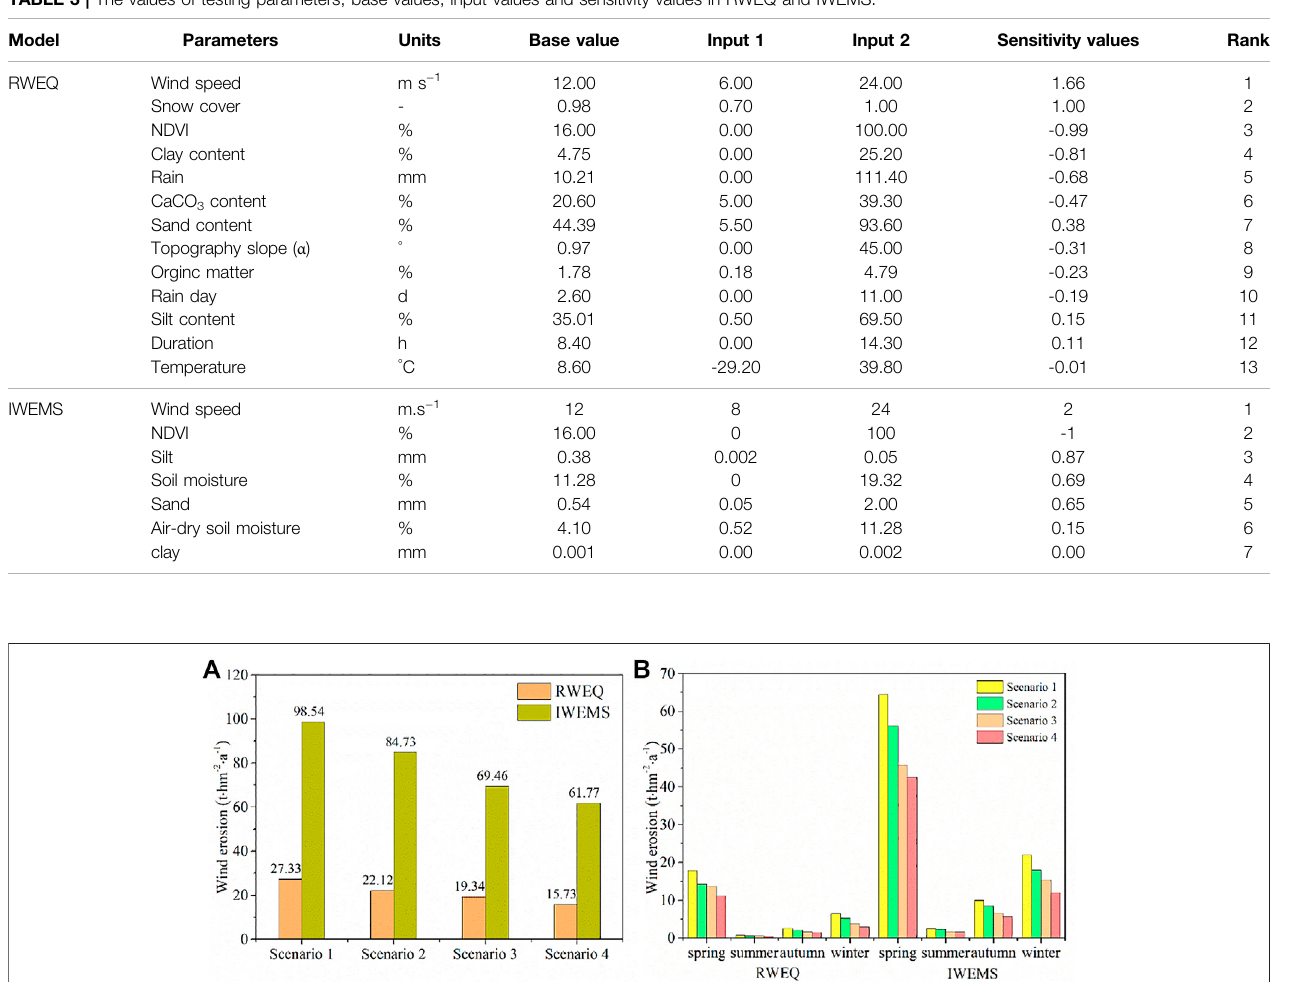
FIGURE 2 | (A) Average potential wind erosion estimated using the RWEQ and IWEMS for different scenarios. (B) Seasonal distribution of the average potential wind erosion estimated using the RWEQ and IWEMS for different